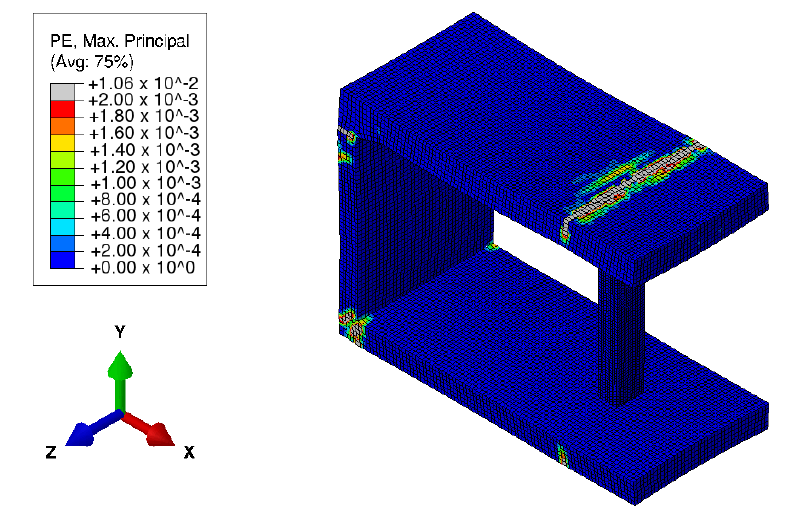
Figure 25. Plastic strains, developed on the outer surface of the top slab at its connection to the column right before the onset of cracking, as obtained from a thermomechanical simulation based on the temperature-dependent and elasto-plastic material behavior, as well as on the prescription of one uniform surface temperature history; the results refer to the time instant 25 min and 1.0 s after the beginning of the fire test.